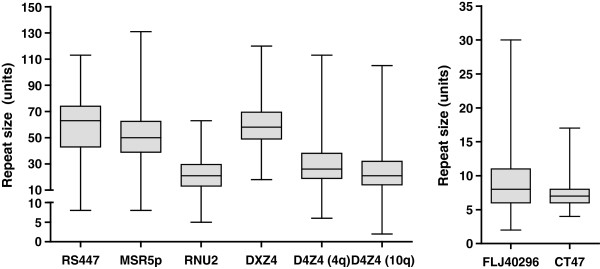
Observed size ranges of the MSR arrays. For every MSR, a box plot illustrates the size range observed in all 210 unrelated individuals. The box indicates the upper and lower quartiles and the median is represented by a horizontal line within the box. The vertical lines show the full range of sizes observed for the MSRs. MSRs are very polymorphic with some showing a wide range of size variation (e.g. MSR5p) and others a much more limited variation (e.g. CT47). The mean repeat array size was also very variable; e.g. RS447 repeats contained on average 60 repeat units in contrast to e.g. FLJ40296 that consisted on average of 9 repeat units. For FLJ40296, RNU2, CT47, D4Z4 (4q) and D4Z4 (10q) MSR array sizes were not evenly distributed where skewness to the longer repeat sizes was observed. A minimum number of two repeat units is required to form a repeat array and this was found for D4Z4 (10q) and FLJ40296, but for the other MSRs higher minimum array sizes were observed. This minimum number of repeat units depended on the MSR and could be rather large, e.g. for RS447 and MSR5p where the shortest repeat array consisted of eight units.